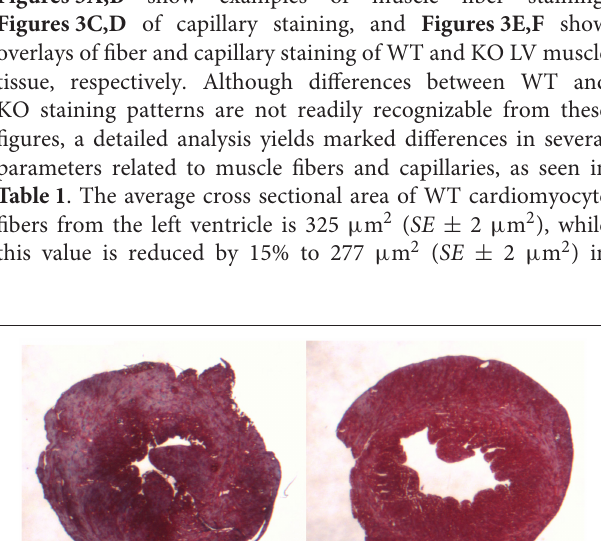
FIGURE 2 | Heart cross sections, taken perpendicular to the longitudinal heart axis, and stained with Masson’s trichrome staining. Animals are those used in the P-V loop measurements. Bar 1